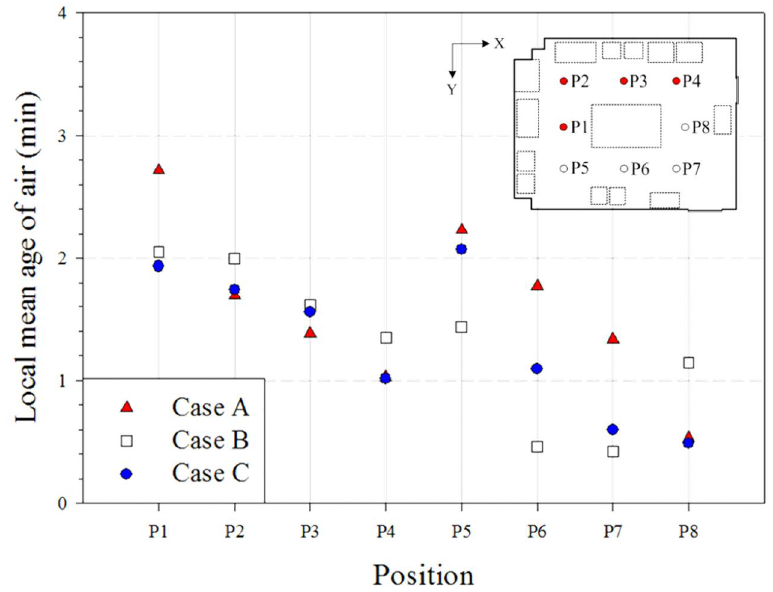
Figure 12. Comparison of mean age of air in each case study.